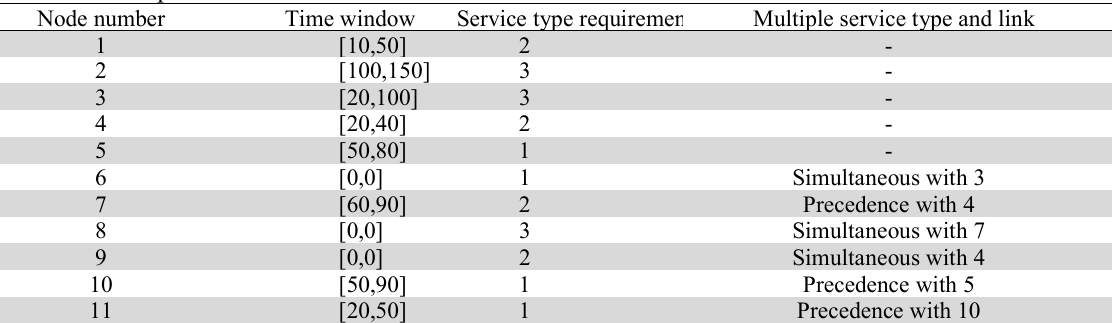
Information of patients